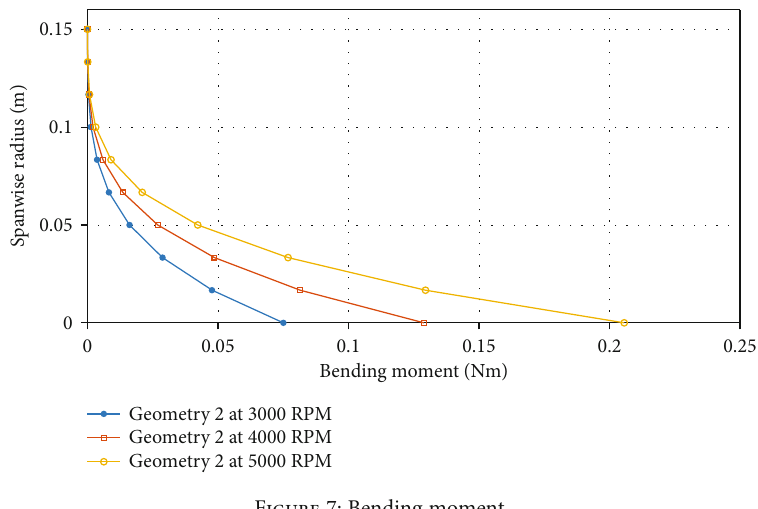
Figure 7: Bending moment.